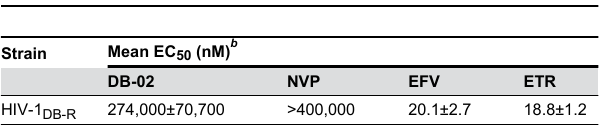
Table 3. Antiviral activity against DB-02 induced resistant virus a .